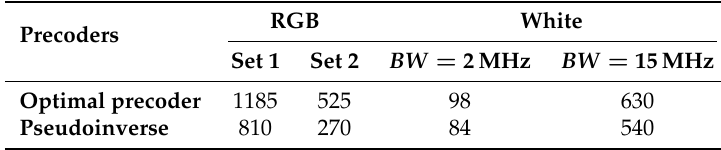
Table 4. Sum rates achieved in [Mb/s] for K = 6 users placed at the specific positions depicted in Figure 5. “RGB” refers to a system with N = 12 RGB units, each unit composed of one red, one green, and one blue LED co-located together. “White” refers to a system with twelve phosphor-coated